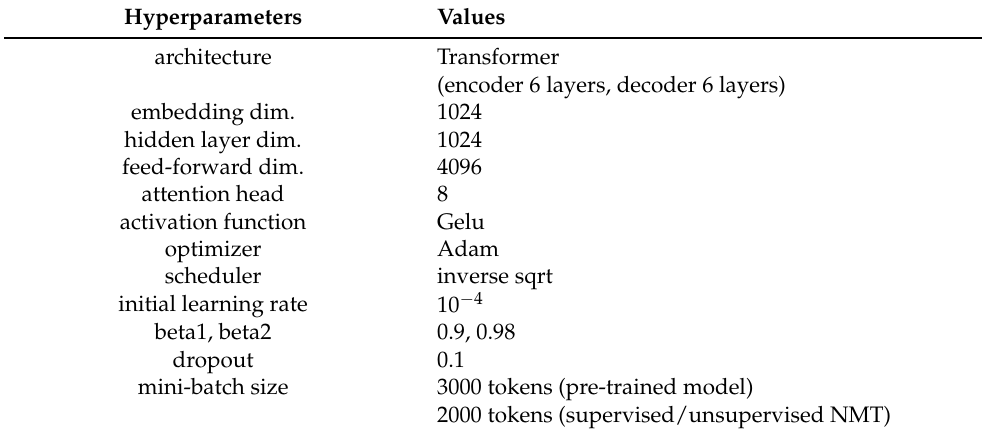
Table 2. The hyperparameters to build the pre-trained model, the unsupervised NMT, and the supervised NMT models.